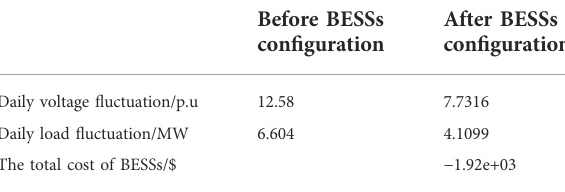
Before BESSs After BESSs con fi guration con fi guration